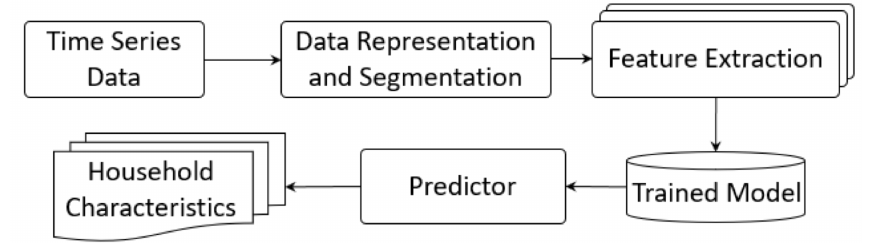
Figure 4. The model prediction to infer the household